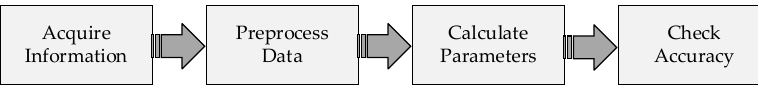
Figure 1. Online estimation process of electric meter errors.